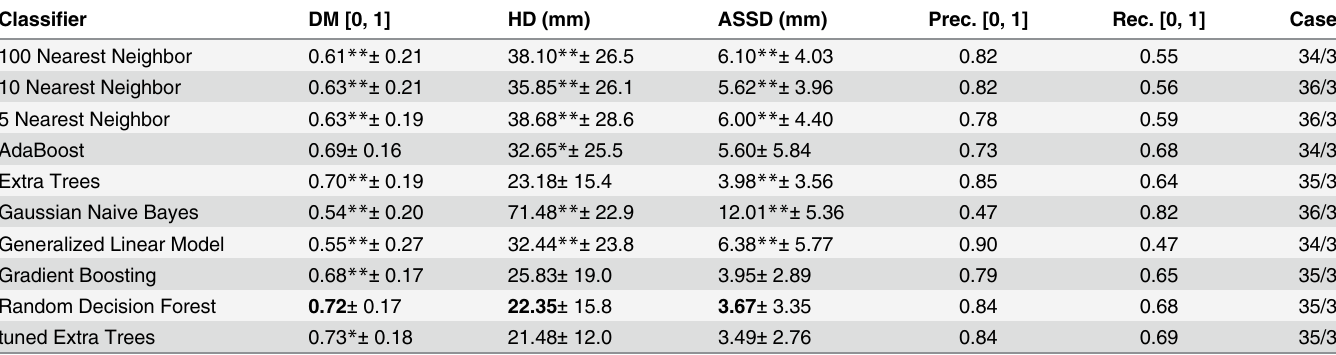
Table 3. Besteffort scenario.